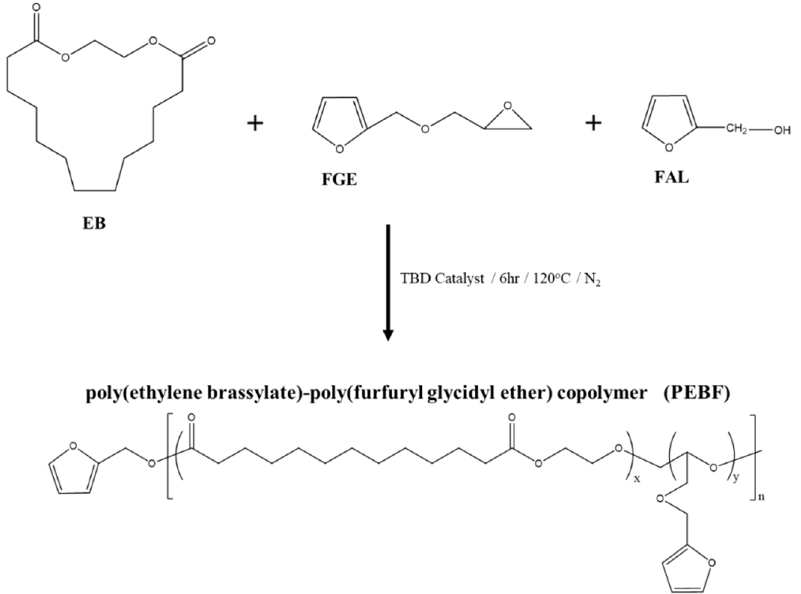
Figure 1. Synthesis of poly(ethylene brassylate)-poly(furfuryl glycidyl ether) copolymer (PEBF) via ring-opening polymerization.